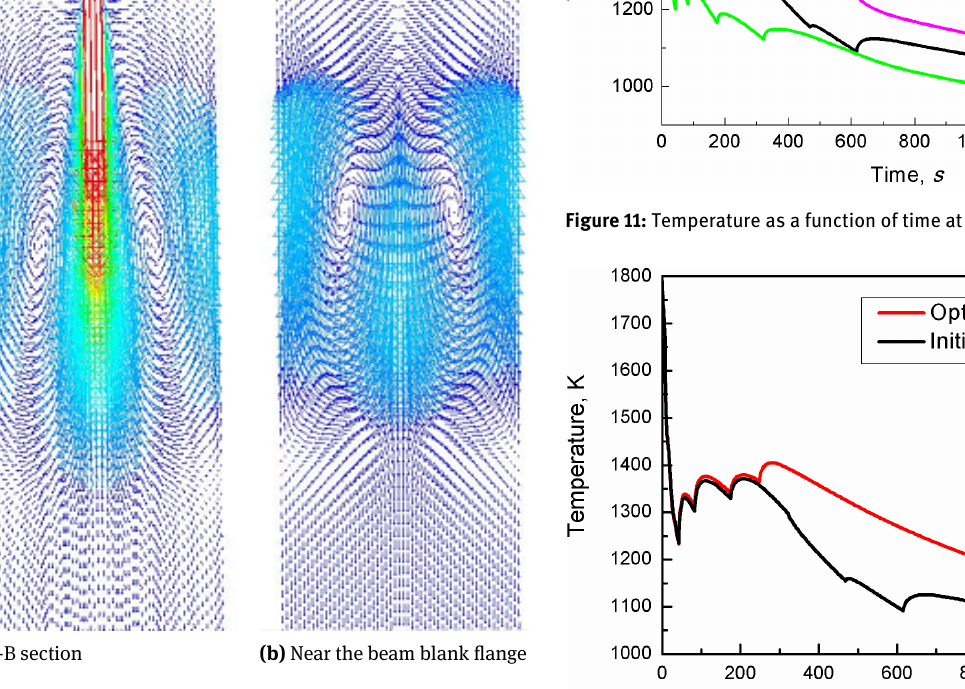
Figure 9: Fluid flow at flange of beam blank.